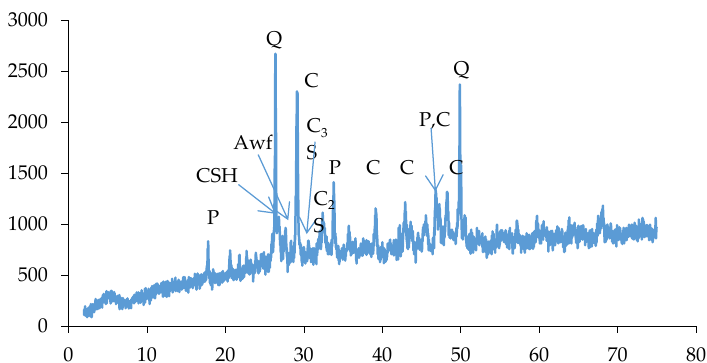
Figure 16. XRD diagram of cement mortar with 80% cement and 20% CSF, where C: calcite, P: portladite, Q: quartz, Awf: Awfillite, CSH: hydrated cement.